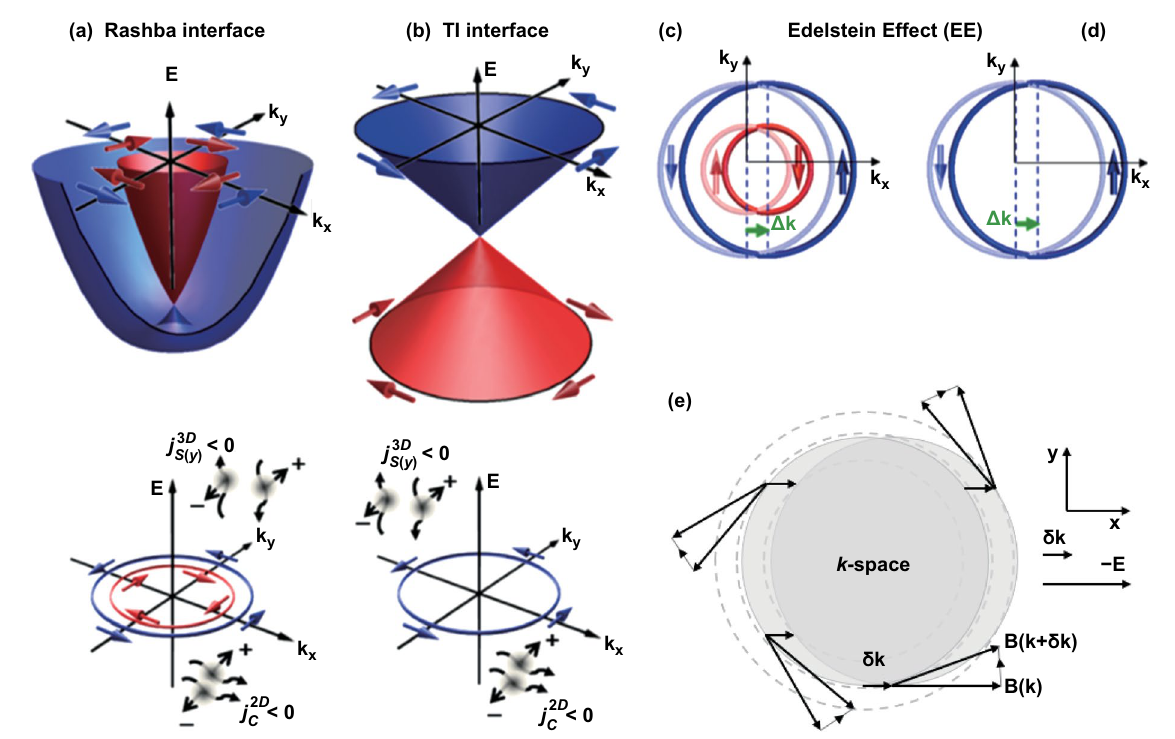
Fig. 5 Edelstein effect. Top: a Energy dispersion surfaces of the 2D states at a Rashba interface and b Dirac dispersion cone of the surface or interface states of a topological insulator. Bottom: a Fermi contours of Rashba states with two contours with helical spin configurations of opposite chirality and b TI surface or interface states. c , d Edelstein effect: A flow of electrons along x ( j TI. 2DEGs are associated with shifts Δ k of the Fermi contours generating an extra population of spin along the direction. (For Rashba, there is a partial compensation of the contributions of the two contours.) e Schematic picture of intrinsic spin–orbit generated spin currents. An electric field in the x ‑direction displaces the Fermi distribution by 𝛿 k . Carriers experience a torque that tilts them according to their spins. The tilting is opposite for opposite momenta and it generates a spin current in the y ‑direction. Figures reprinted with permission from Ref.